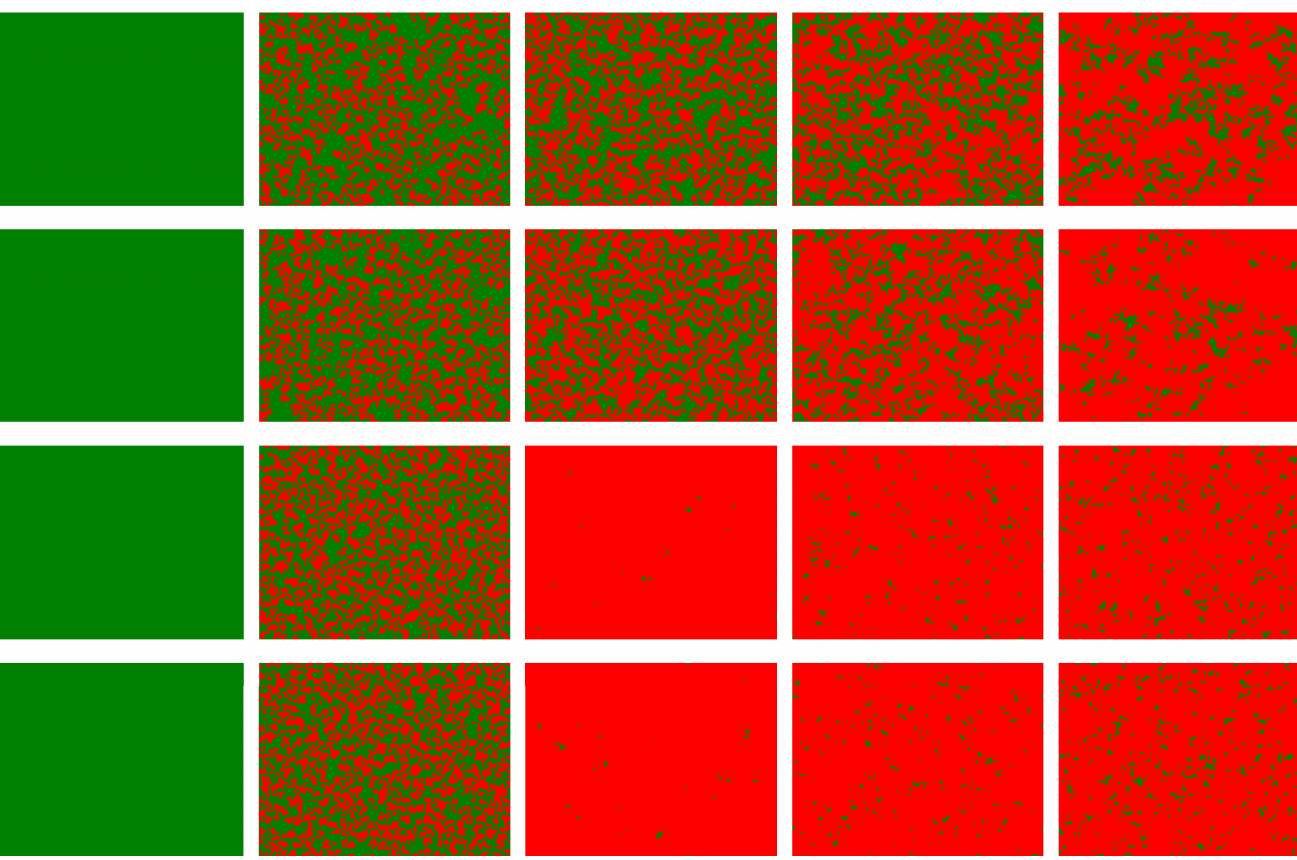
Fig 3. Characteristic patterns between cooperators and defectors on two interdependent lattices at MCS = 50000 when A is changed from 0 to 1.0. The panels for the first two rows denote the distribution of cooperators and defectors for the upper lattice and lower lattice in the case II ; while the bottom two rows of panels represent the evolutionary patterns of players for the case I . In all these panels, red dots stand for cooperators and green dots represent defectors. From these figures, it is clearly shown that the fraction of cooperators is largely enhanced as A increases, meanwhile the cooperative pairs (C-C type coupling way) have the predominant advantage and dominate the evolutionary behavior on interdependent lattices. In particular, the designating way of the coupling strength between players on interdependent lattices can also affect the evolution of cooperation. The simulation parameters are set as follows: MCS = 50000, b = 1.05, L = 200 and K = 0.1, and A is varied from 0 to 1.0 with the step length 0.25 (from the left panels to the right